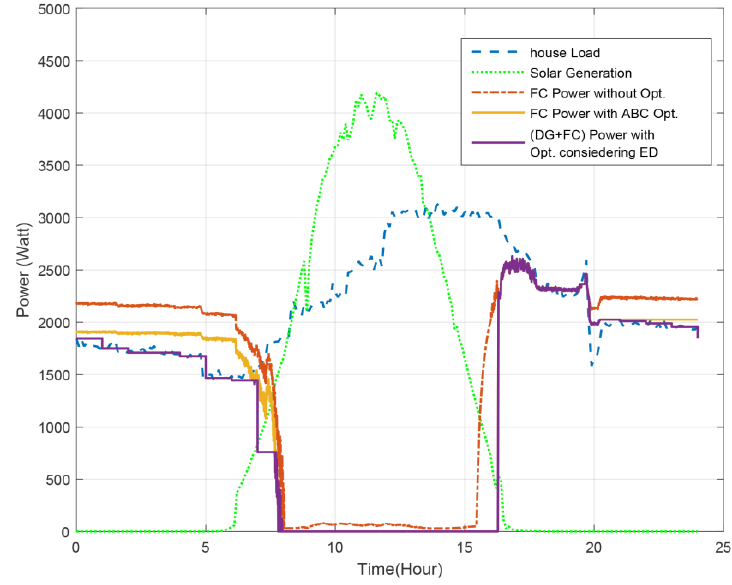
Figure 20. Operation of the microgrid backup system in three di ff erent scenarios on July 28th, 2016.